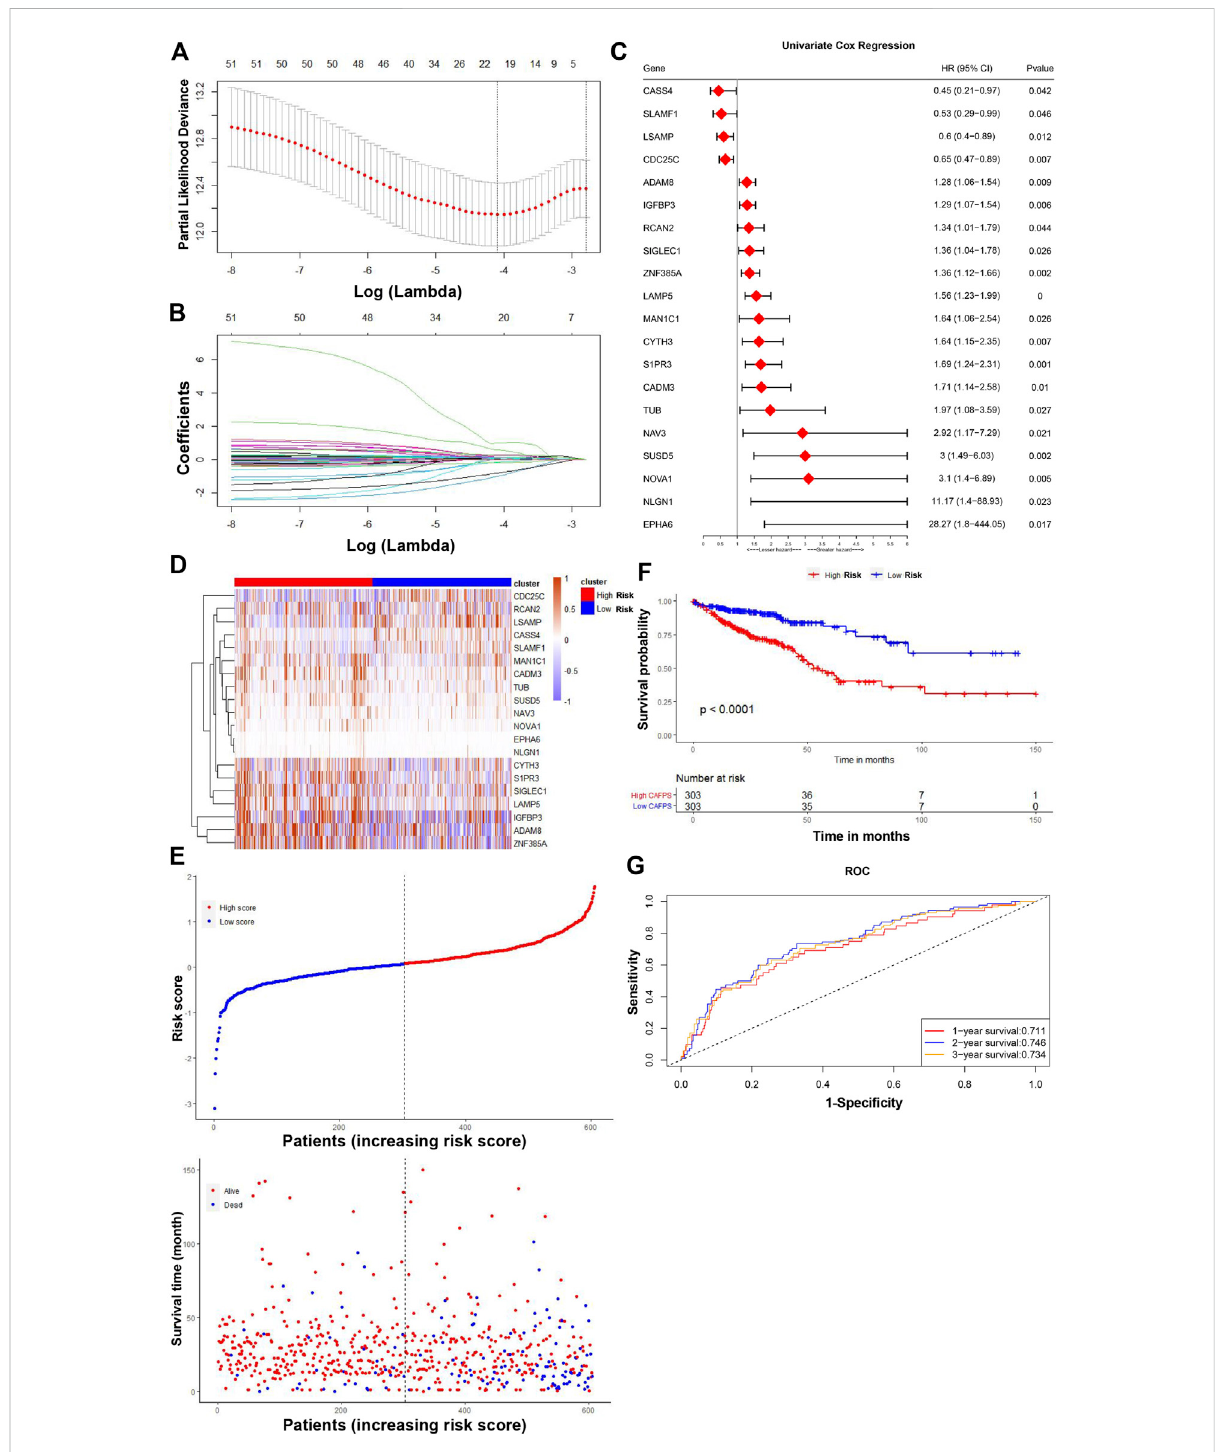
FIGURE 6 Screening of signature genes and the prognostic value of the CAFs-related signature in TCGA cohorts. (A) Ten-fold cross-validations for the screeningofoptimalparameter(lambda). (B) LASSOcoef fi cientpro fi lesdeterminedbytheoptimallambda. (C) TheforestplotpresentedtheHRsand p -values from the univariate Cox regression as well as the LASSO coef fi cient of the twenty prognostic signature genes. (D) Heatmap visualizing the expression levels of twenty prognostic CAFs genes with the CAFs risk scores in the TCGA cohort. (E) The distribution of patient survival status ranked by corresponding risk scores. (F) The Kaplan-Meier survival curves of OS between high and low risk score groups. (G) The time-dependent ROC curves of the prognostic signature for 1-, 2-, and 3-year overall